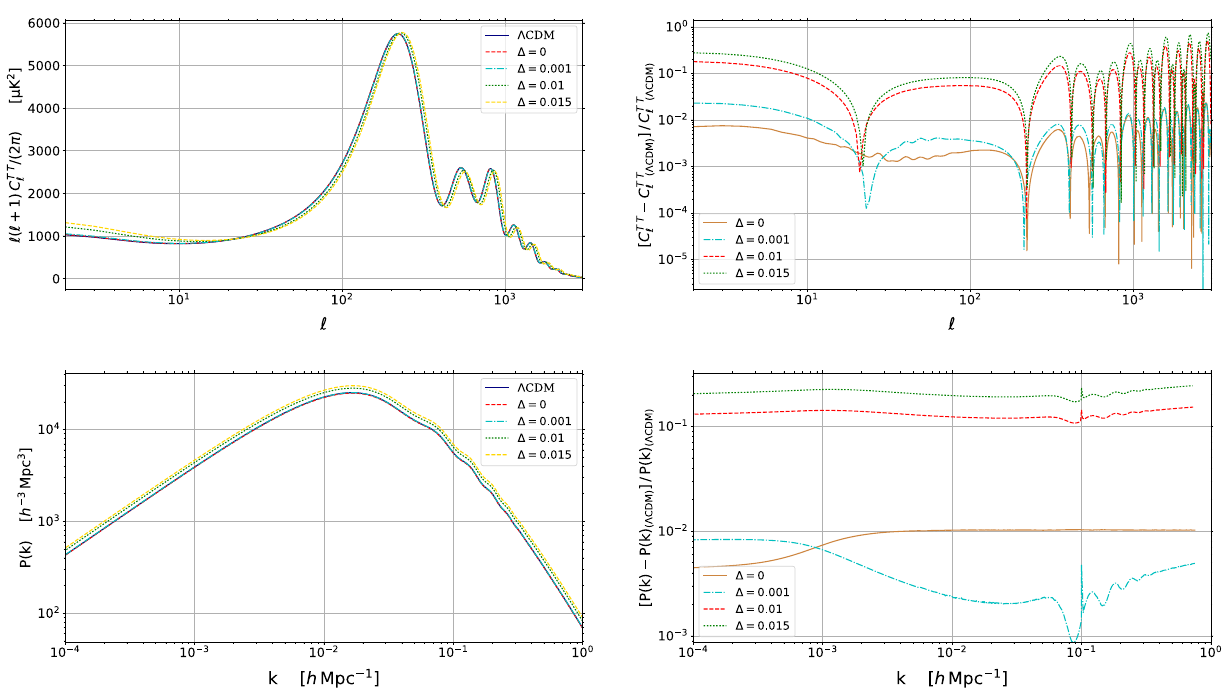
Fig. 1 The CMB power spectra (upper left) and their relative ratios with respect to (cid:3) CDM (upper right) for different values of (cid:2) . Lower panels show the analogous diagrams for the matter power